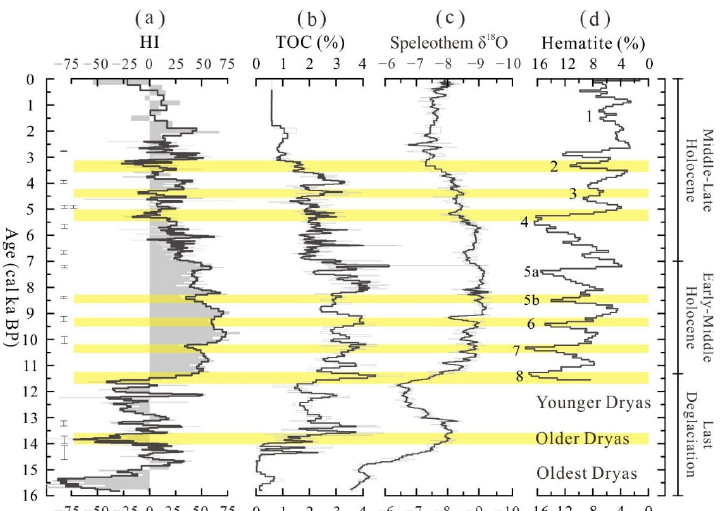
Figure 7. ( a ) Humidity index (HI) of core AGL ‐ 2010. The dark line represents the three ‐ point running mean of the HI score. ( b ) TOC content of core AGL ‐ 2010 [21]. ( c ) Dongge Cave speleothem δ 18 O records [35]. ( d ) Hematite ‐ stained grain concentration from the North Atlantic [39]. Yellow bars mark dry events on a multi ‐ centennial scale in Anguli ‐ nuur lake. In summary, the HI score exhibits a good correlation with the TOC content in the same core, as well as with the stalagmite record and the Bond events. Such a good agree ‐ ment indicates that the grain ‐ size record from Anguli ‐ nuur lake is sensitive in response to moisture variability in northern China. 5. Conclusions The grain ‐ size EMMA method is used to study the provenance, transport processes and sedimentary environment of core sediment from Anguli ‐ nuur lake. Our results show that four EMs are unmixed from the multi ‐ mode grain ‐ size distribution and that their scores are extracted from the whole core sediment. In terms of sedimentary dynamics, three transport processes are revealed, including the runoff, wave and aeolian processes. The HI synthesized by runoff and aeolian EMs in core AGL ‐ 2010 is used to recon ‐ struct the humidity variability since the last deglaciation. The Holocene optimum is iden ‐ tified in early and middle Holocene, which is in agreement with previous conclusions from the same core. Meanwhile, our records document a series of millennial ‐ and multi ‐ centennial ‐ scale dry events, which are well correlated with the Bond events in the North